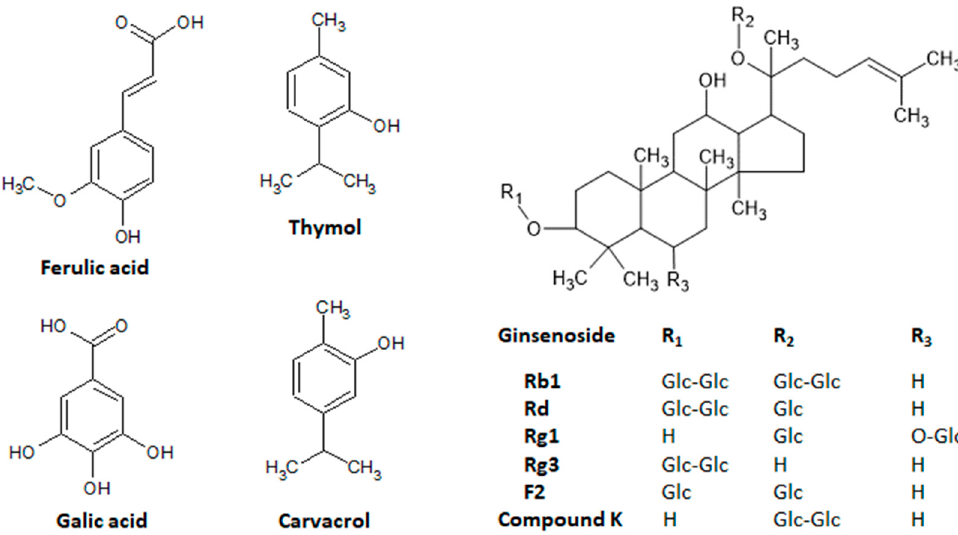
Figure 7. Main natural compounds of plant origin with promising skin anti-aging properties. Chem- ical structures were drawn using ACD/ChemSketch software. cal structures were drawn using ACD/ChemSketch